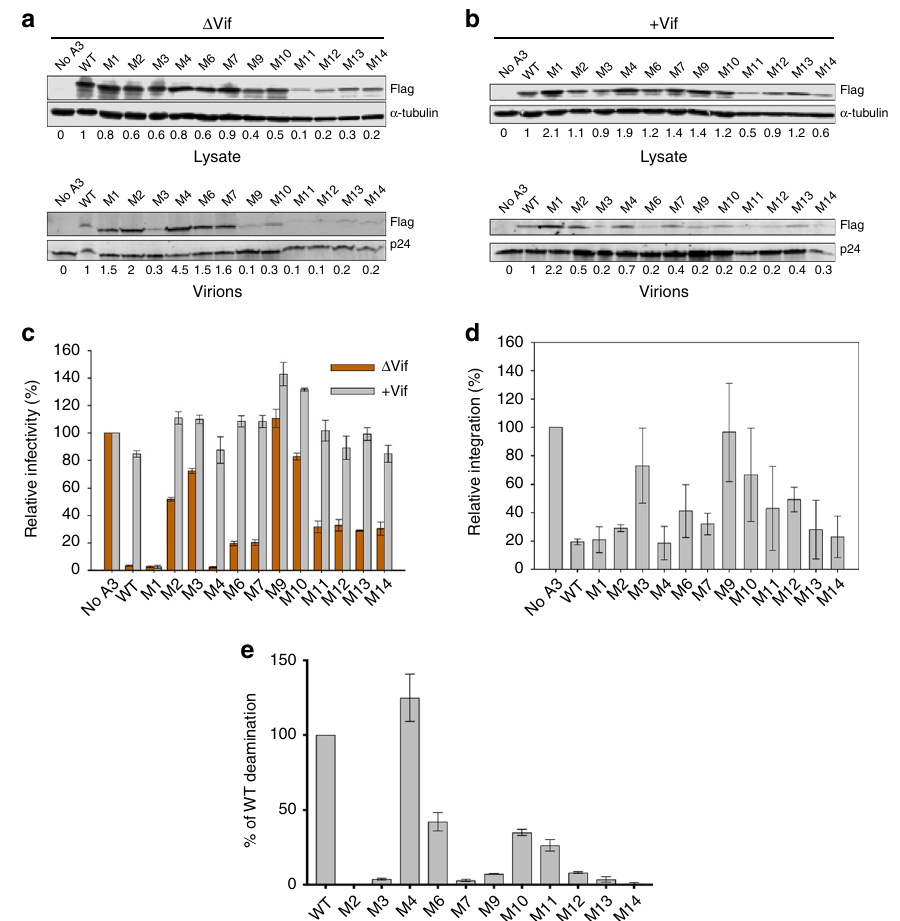
Fig. 4 Virion encapsidation and restriction by A3G wild type and mutants. a , b Immunoblotting with FLAG antibody was used to detect transfected A3G wild type and mutants expressed in 293T virus producer cells and encapsidated into VSV-G pseudotyped virions in the absence, Δ Vif (A) or presence, + Vif (B) of the A3 antagonist, Vif. The cell lysate and virion loading controls were α -tubulin and p24, respectively. The relative A3G levels shown below blots were calculated by setting the A3G wild type condition to 1 and determining the relative values of other lanes. One representative blot from three independent experiments is shown. c Infectivity in the absence or presence of Vif was measured by β -galactosidase activity in TZM-bl reporter cells. Results were normalized to the no A3 condition. Error bars represent the standard deviation of the mean calculated from three independent experiments. d The relative amount of proviral DNA integration in infected 293T cells in the presence of A3G wild type and mutants in comparison to the No A3 condition was determined by qPCR. Error bars represent the standard deviation of the mean calculated from at least two independent experiments. e The result of deaminase activity assay in lysates from 293T cells expressing hA3G and mutants. Error bars represent the standard deviations of the mean calculated from three independent experiments. Source data are provided in the Source Data